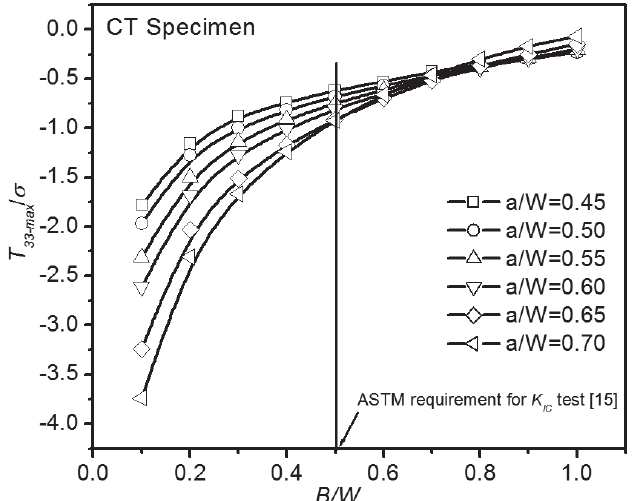
Figure 9: Variation of T 33 /  against B/W for various